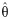
Disparity thresholds from Experiments 1 (2AFC_g), 2 (4AFC_g), & 3 (4AFC_l).Left panels show the stereoacuity thresholds (log10(arcsec)) as a function of age. Right panels show the distribution of thresholds for each experiment. A. Results from Experiment 1. B. Experiment 2; C. Experiment 3. Green dots are the individual thresholds obtained from the fitting that correspond to a probability of correct response of 0.75. The red dots in panels A and B correspond to the thresholds of the participants described in Fig 3. Black lines are fitted regression lines (dashed lines: 95% regression confidence interval for the mean). A. θ^(age)2AFC_g = 1.919–0.323×log10(age). B. θ^(age)4AFC_g = 1.974–0.441×log10(age). C. θ^(age)4AFC_l = 1.69–0.123×log10(age). Top left of left panels shows the Pearson correlation between age and thresholds (log10(age) and log10(arcsec)).